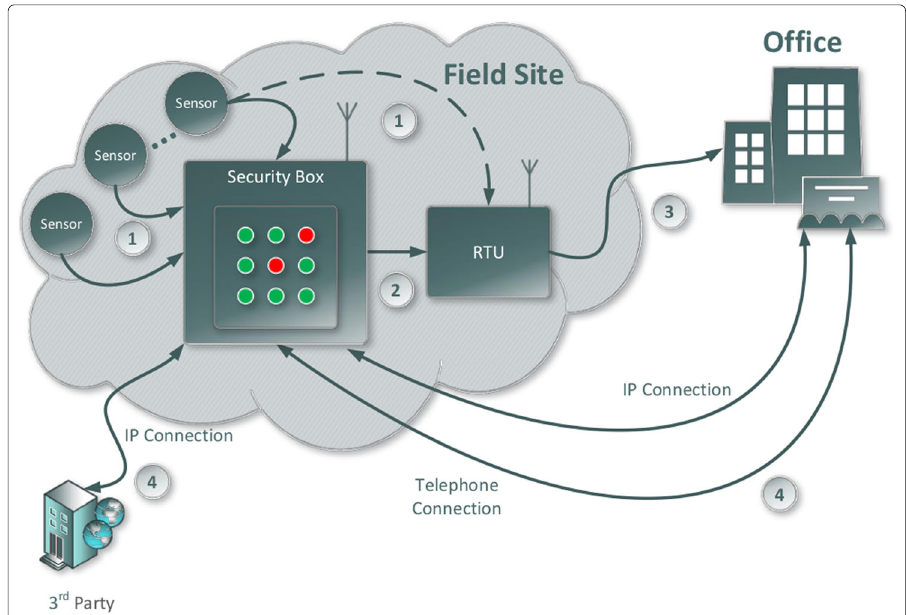
Fig. 1 Simple surveillance architecture for utility